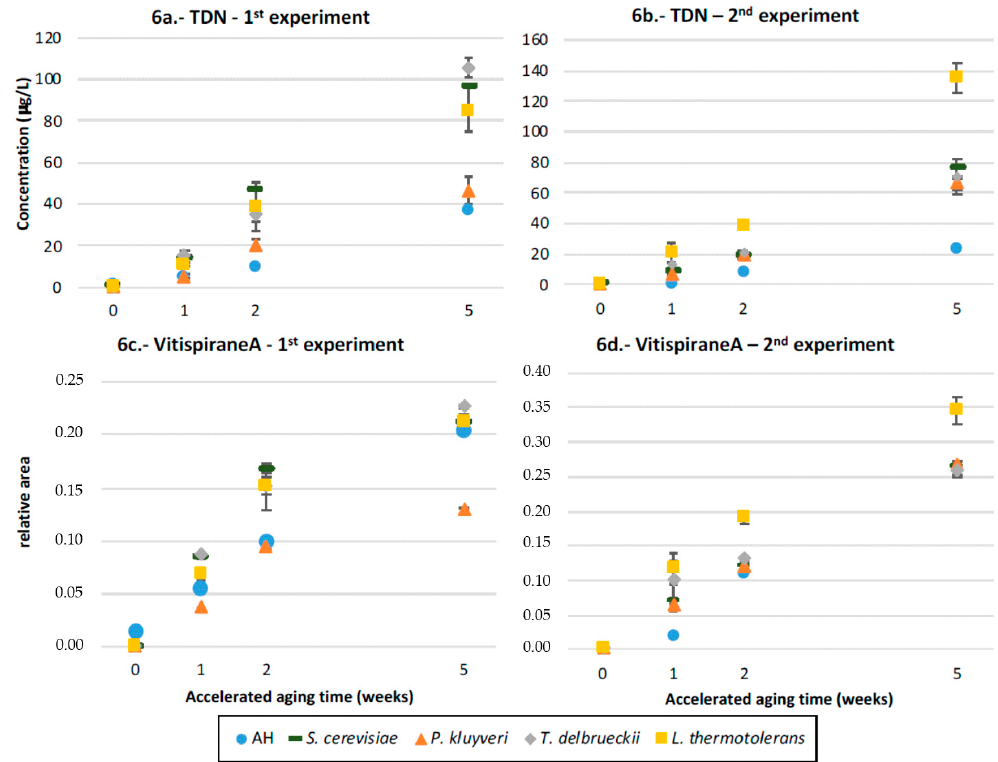
Figure 6. The norisoprenoids evolution in Riesling and Garnacha: the evolution of ( a , b ) TDN and ( c , d ) vitispirane A in wines fermented with di ff erent yeast strains or unfermented controls spiked with glycosidic precursors from Riesling (1st experiment) and Garnacha (2nd experiment) and its evolution during accelerated aging. The vitispirane samples are given in the relative